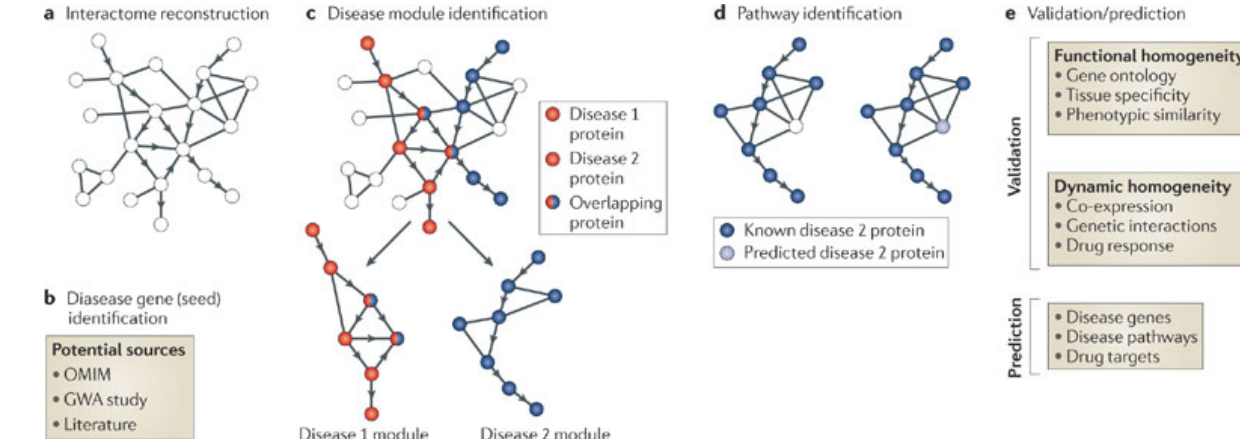
Figure 1. The methodological steps by which network medicine identifies disease modules and predicts novel protein targets for